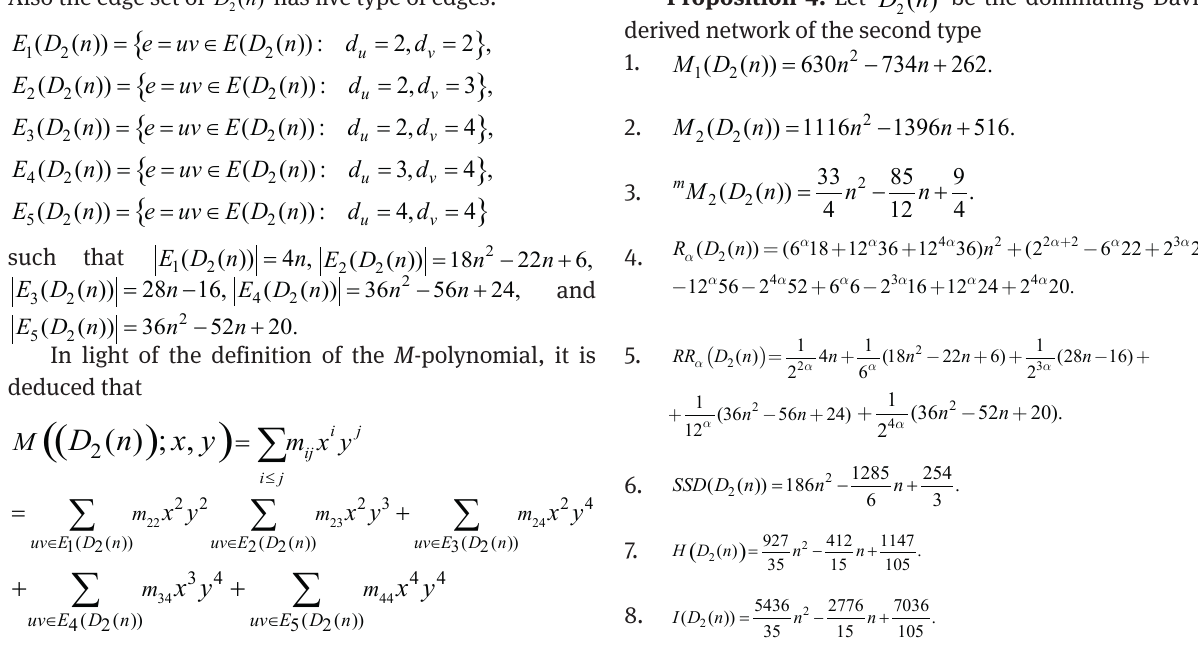
Figure 14 is plotted using Maple 15. This suggests that values obtained by M-polynomial show different behaviors corresponding to different parameters x and y . We can control these values through these parameters. Now some degree-based topologcal indices of the dominating David derived network of the second type are computed from this M -polynomial.